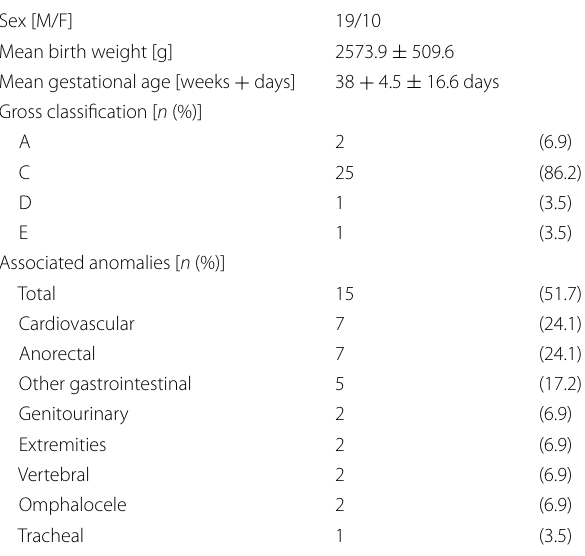
Table 1 Characteristics of 29 patients with esophageal